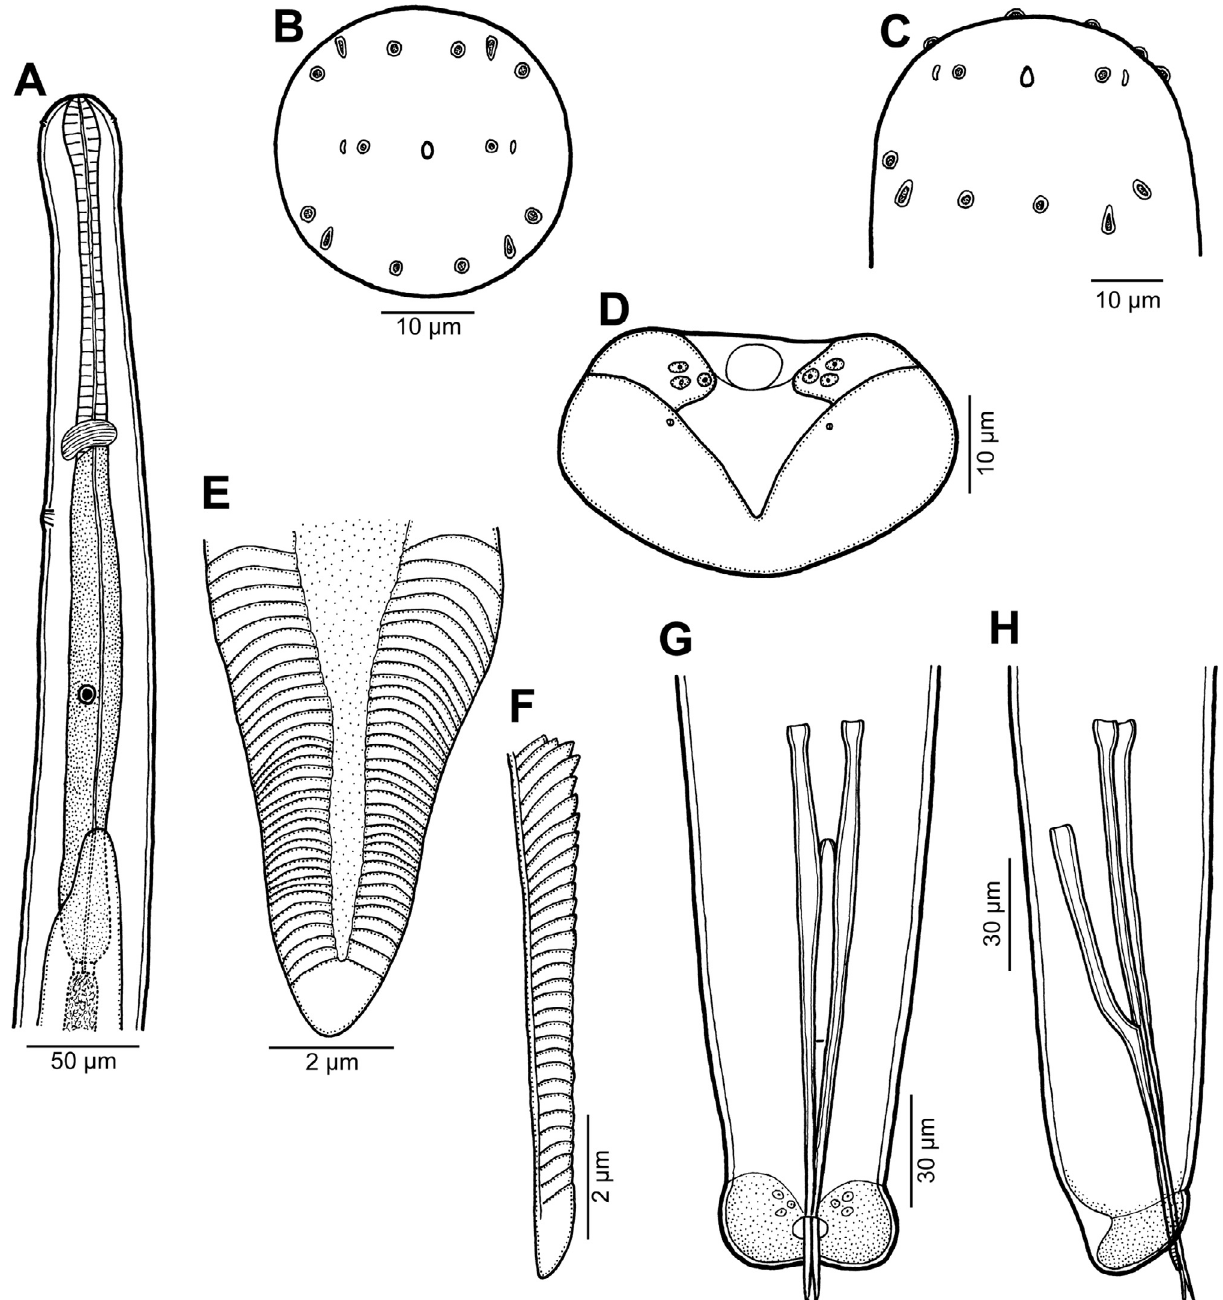
Figure 3. Male of Philometra piscaria n. sp. from Epinephelus coioides . A: Anterior end of body, lateral view. B, C: Cephalic end, apical and subdorsoventral views. D: Caudal end, apical view. E, F: Distal end of gubernaculum, dorsal and lateral views. G, H: Posterior end of body, ventral and lateral